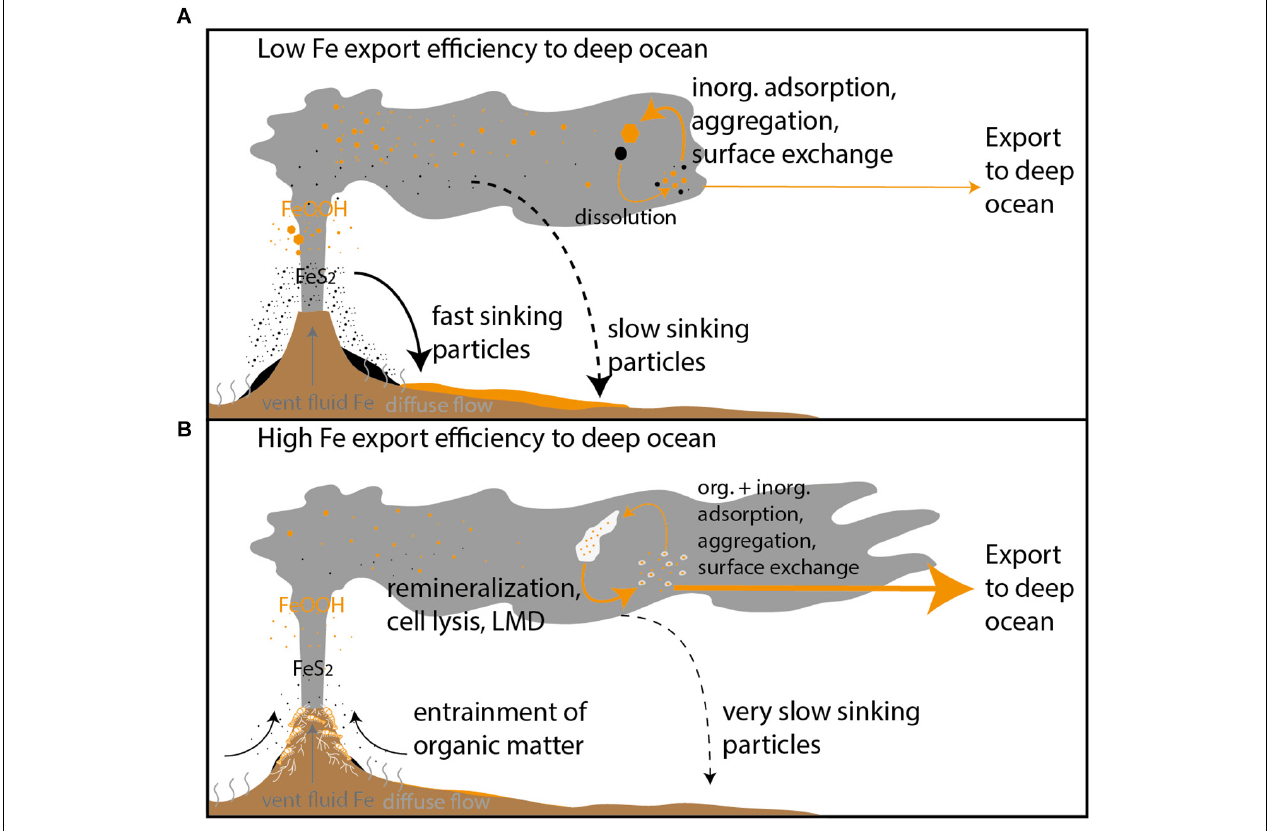
FIGURE 7 | Conceptual model of the two extremes of the Fe cycle within a typical hydrothermal plume where processes of inorganic (inorg.) Fe particle formation dictate Fe chemistry enhancing Fe removal to sediments (A) and where biological processes and organic (org.) matter favor the retention of Fe within the deep ocean reservoir (B) . LMD is an abbreviation for ligand mediated